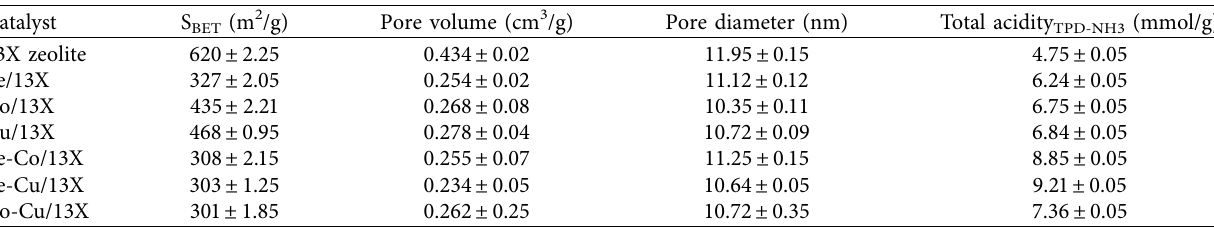
Table 3: Surface area ( S BET ), pore volume ( V p ), pore diameter ( d p ), and acidity of 13X zeolite and metal-modified 13X zeolite catalysts. Catalyst